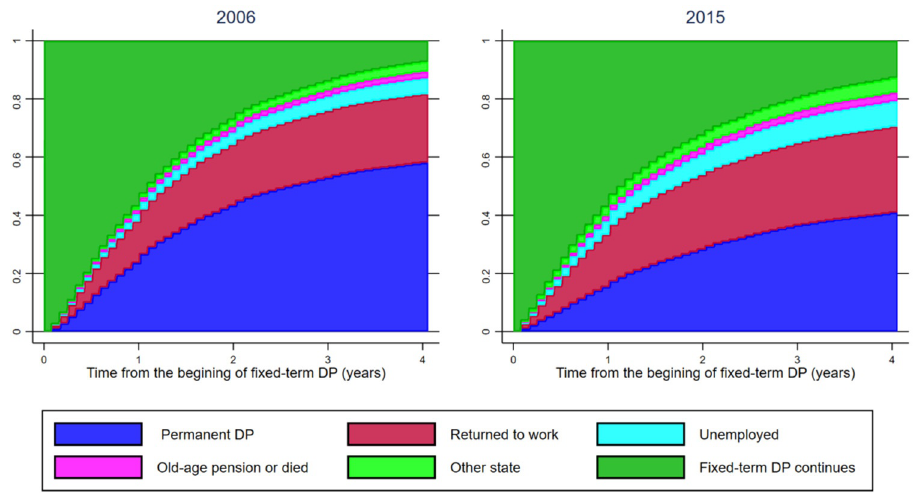
Figure 1. Cumulative incidence of permanent disability pension (DP), return to work, and the other labor market states over a four-year follow-up period among those who started receiving a fixed-term disability pension in 2006 and 2015.